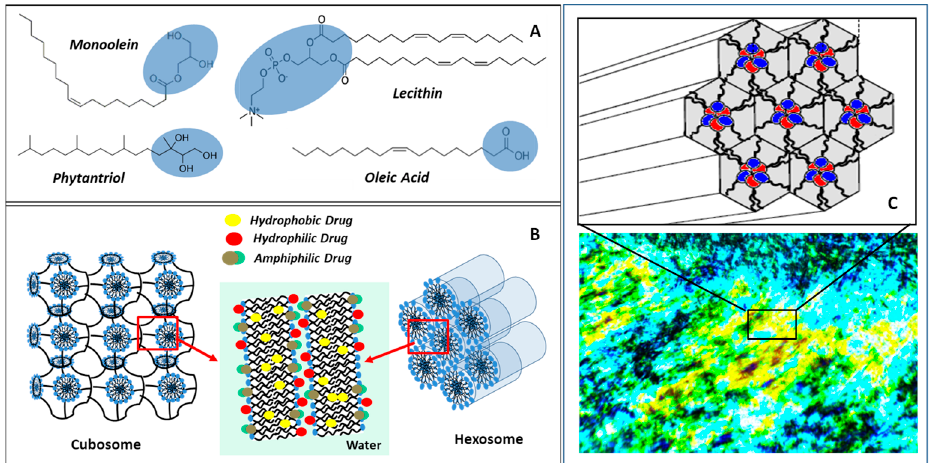
Figure 5. Some of the most commonly used amphiphiles for the construction of liquid crystalline (LCs) nanostructures ( A ). Typical bicontinuous gel-like cubic and inverted hexagonal phases contain hydrophilic and hydrophobic compartments which can encapsulate hydrophilic or lipophilic guest compounds (drugs) ( B ). Polarized optical micrographs of an equimolar bis(2-ethylhexyl) phosphoric acid/n-octylamine mixture ( C ), and the 2D hexagonal molecular rearrangement at the basis of the LCs structure (top).